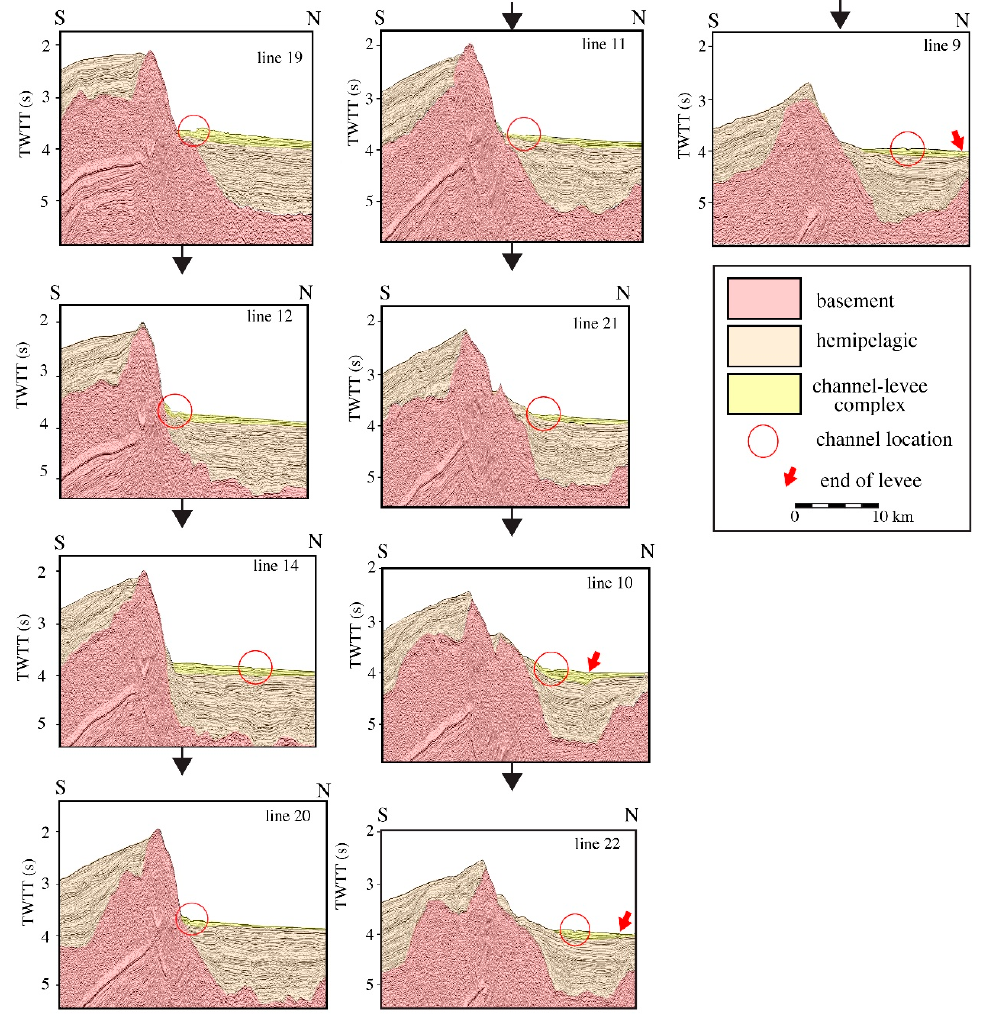
Figure 4. Multichannel seismic-reflection profiles (EW9905) collected by Tréhu et al. [25] and accessed at www.geomapapp.com. TWTT is two-way travel time. Red circle surrounds location of Mendocino Channel; red arrow is location of the distal end of the levee. Large black arrows show the progression of seismic lines from east to west. No channel was resolved on lines 6, 8 and 23. USC is upper side channel (see canyon discussion below).